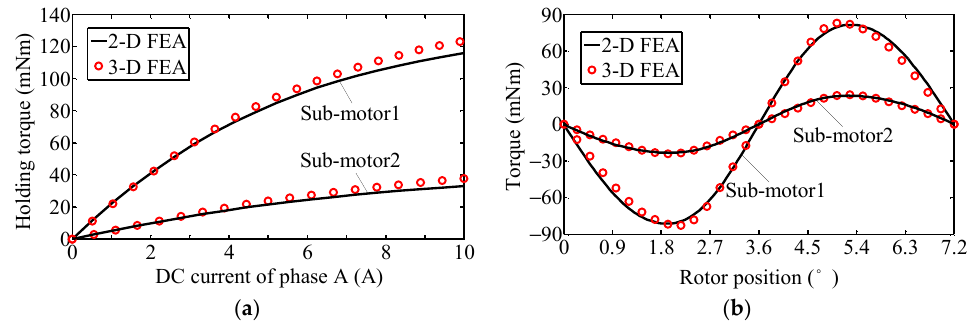
Figure 13. Comparison of the torque properties by 3-D and 2-D FEA. ( a ) Holding torque property; ( b ) Torque-angle property with rated current excitations.